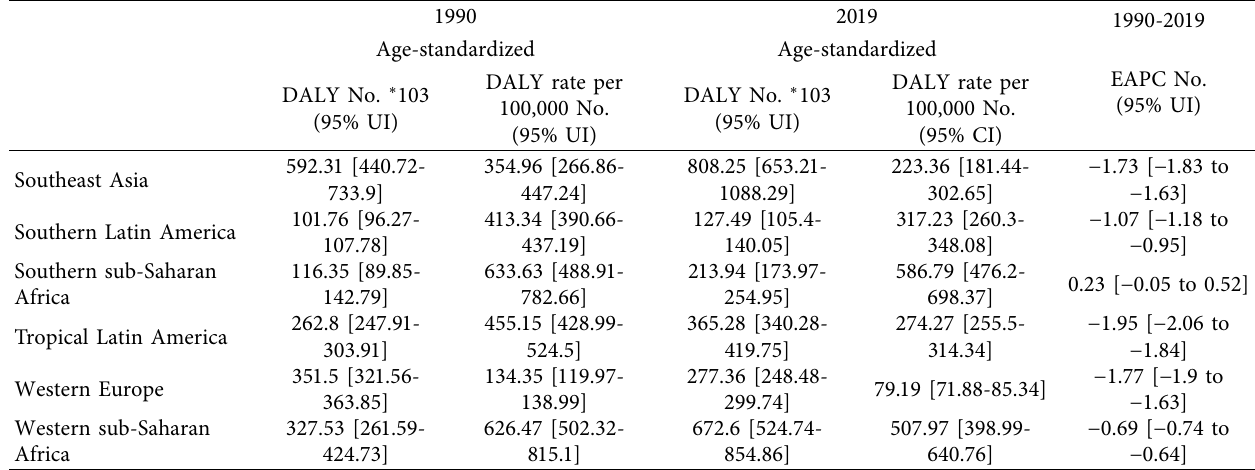
Table 3: Disability-adjusted life-years, age-standardized disability-adjusted life-years, and temporal trends of cervical cancer from 1990 to